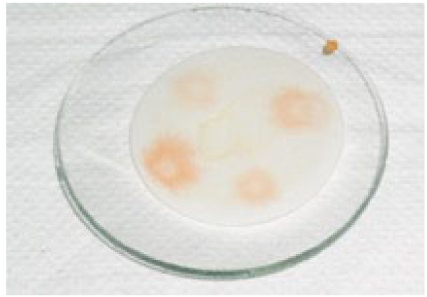
Figure 4. Red coloration due to the presence of orthophenanthroline hydrochloride inside the